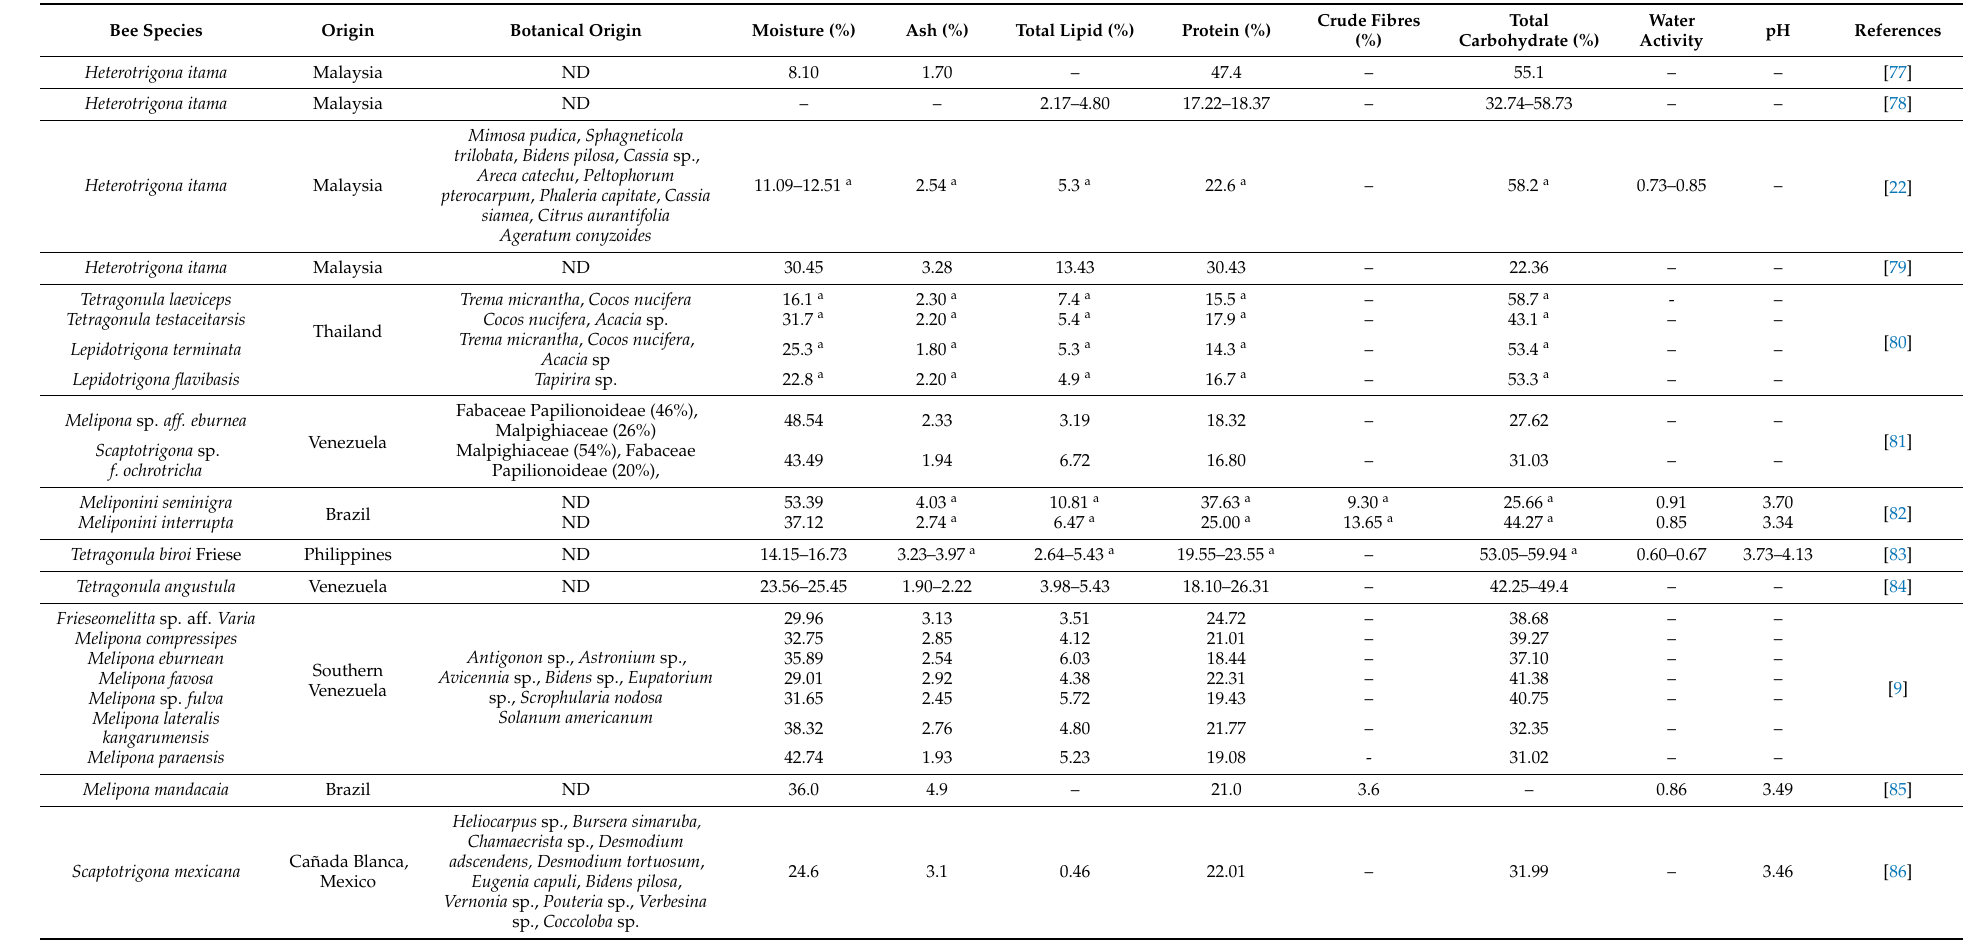
Table 1. Chemical analysis of bee bread from stingless bee across different geographical